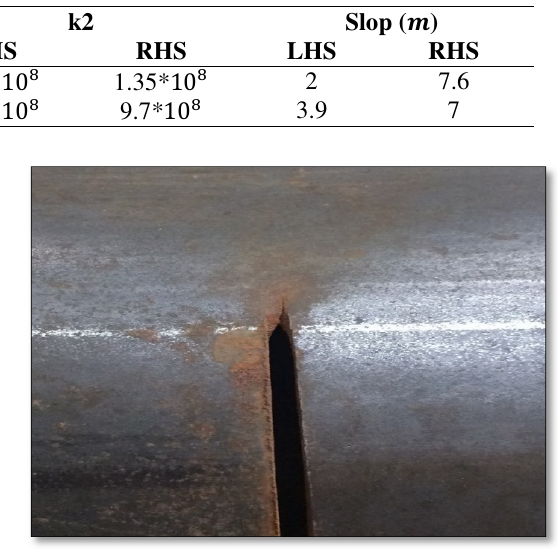
Fig.7. Close up photo show the crack and crack growth.